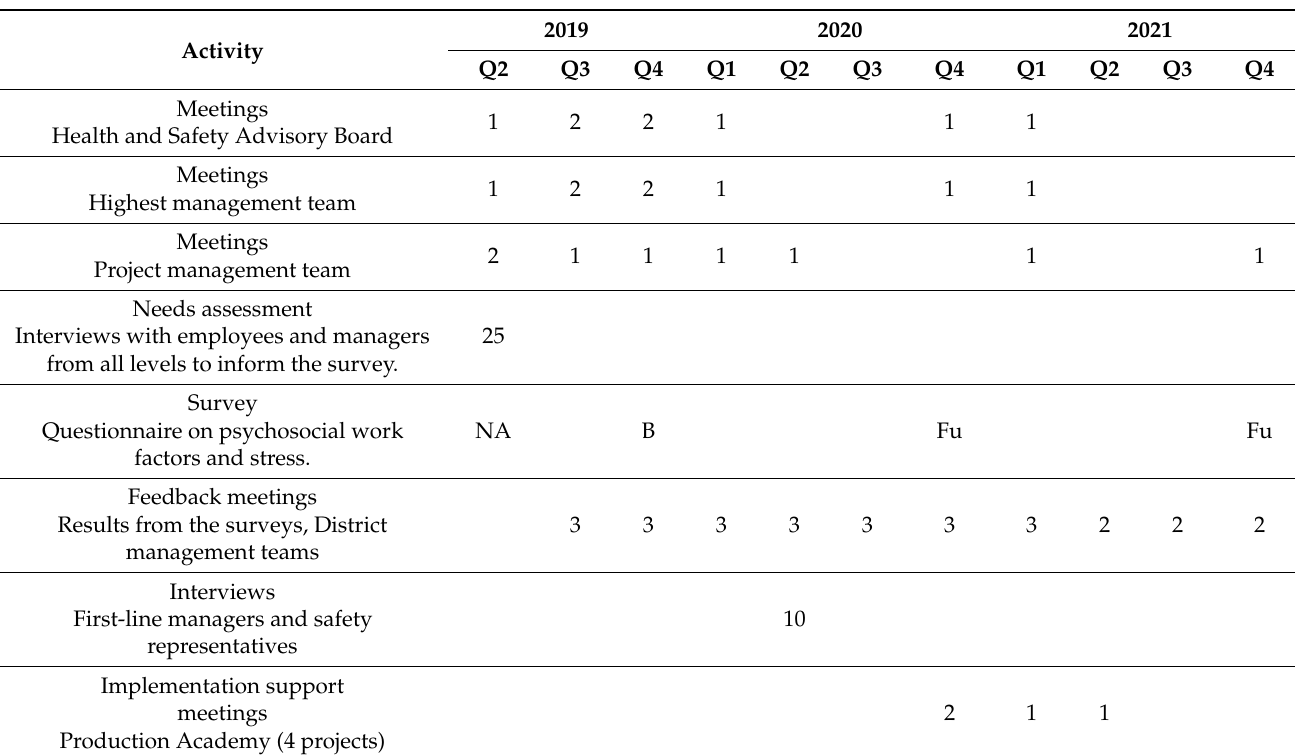
Table 1. Number of activities included in the co-creation process and when in time they occurred.